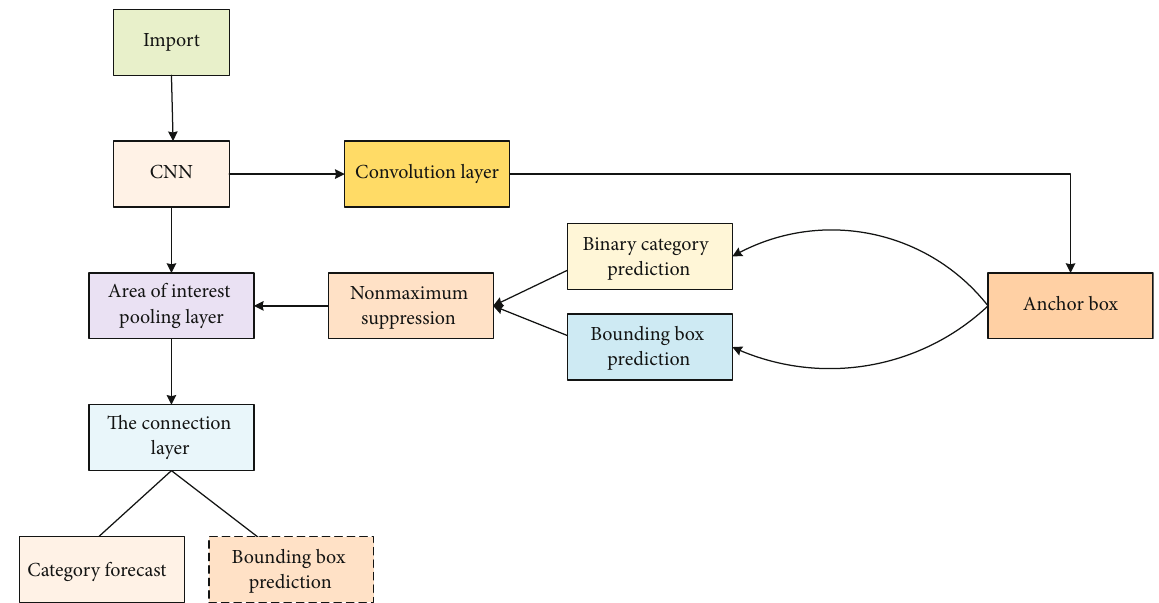
Figure 2: Flow of image